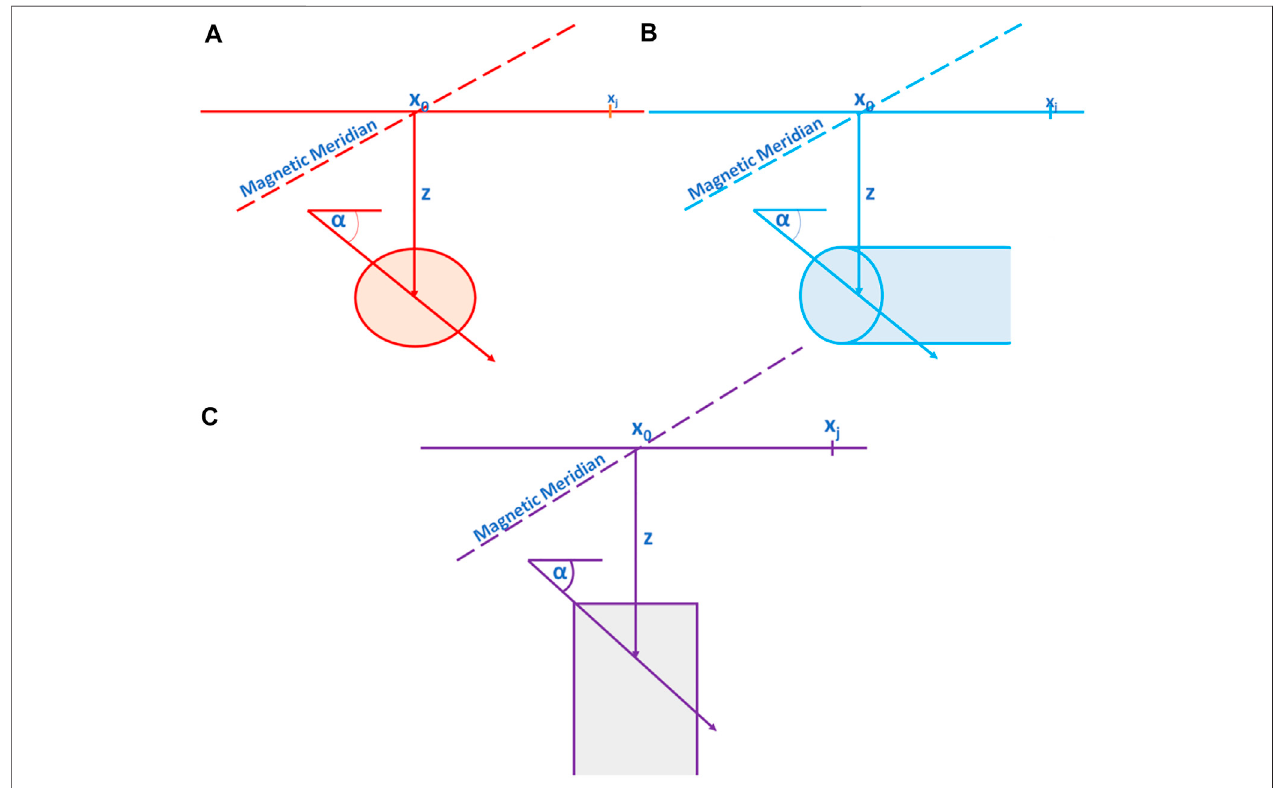
FIGURE 1 | Schematic cross-sections showing con fi gurations of simple geometrical shaped models and their parameters; (A) Sphere (B) Horizontal cylinder (C) Thin sheet.